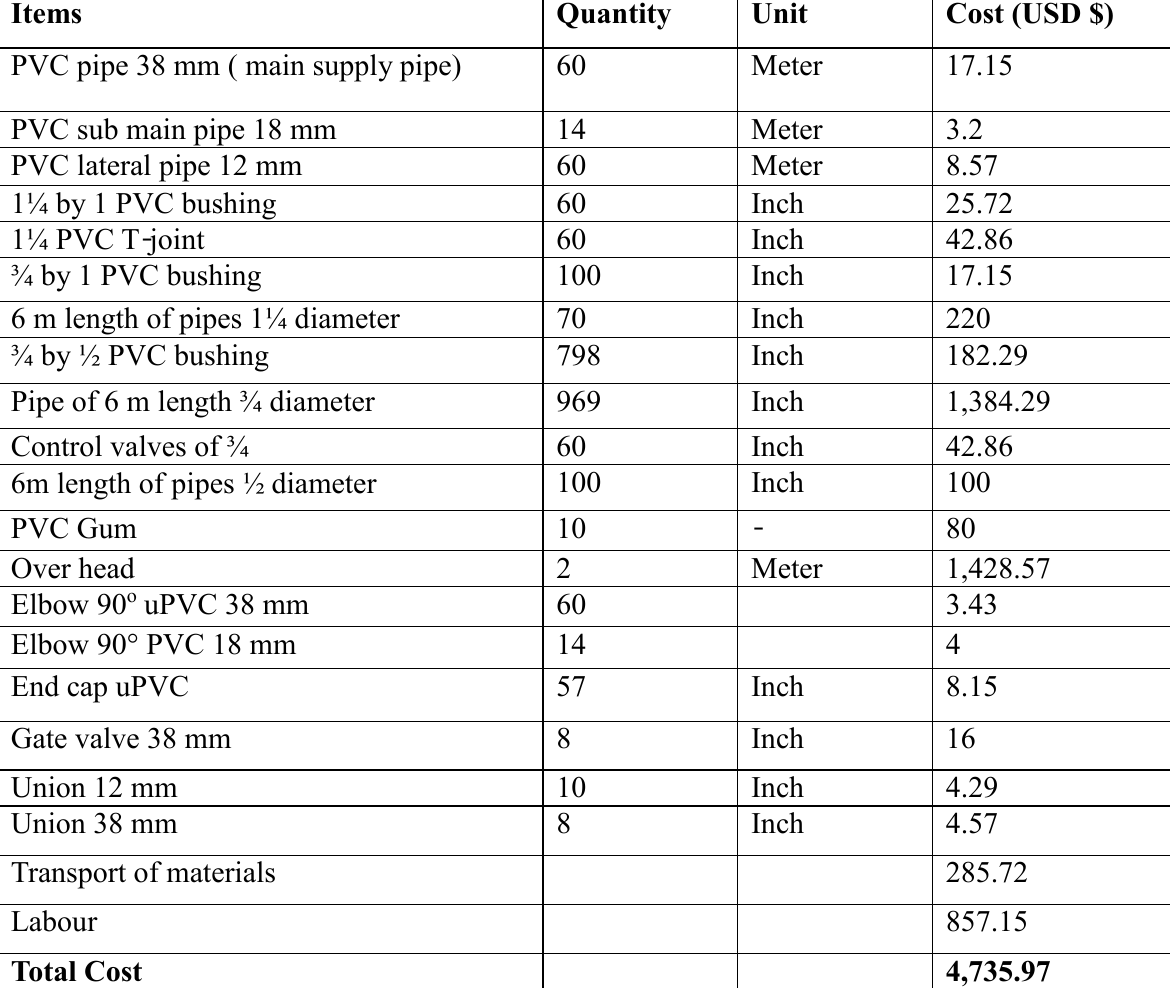
Cost break down for designing and installing the system